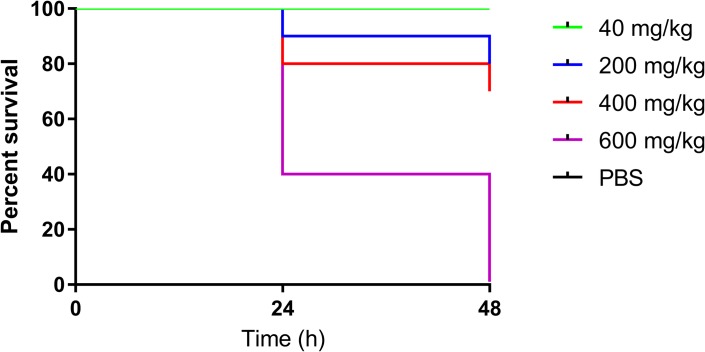
Survival curve showing in vivo toxicity of [Mn(CO)3(tpa-κ3N)]Br against Galleria mellonella over 48 h.